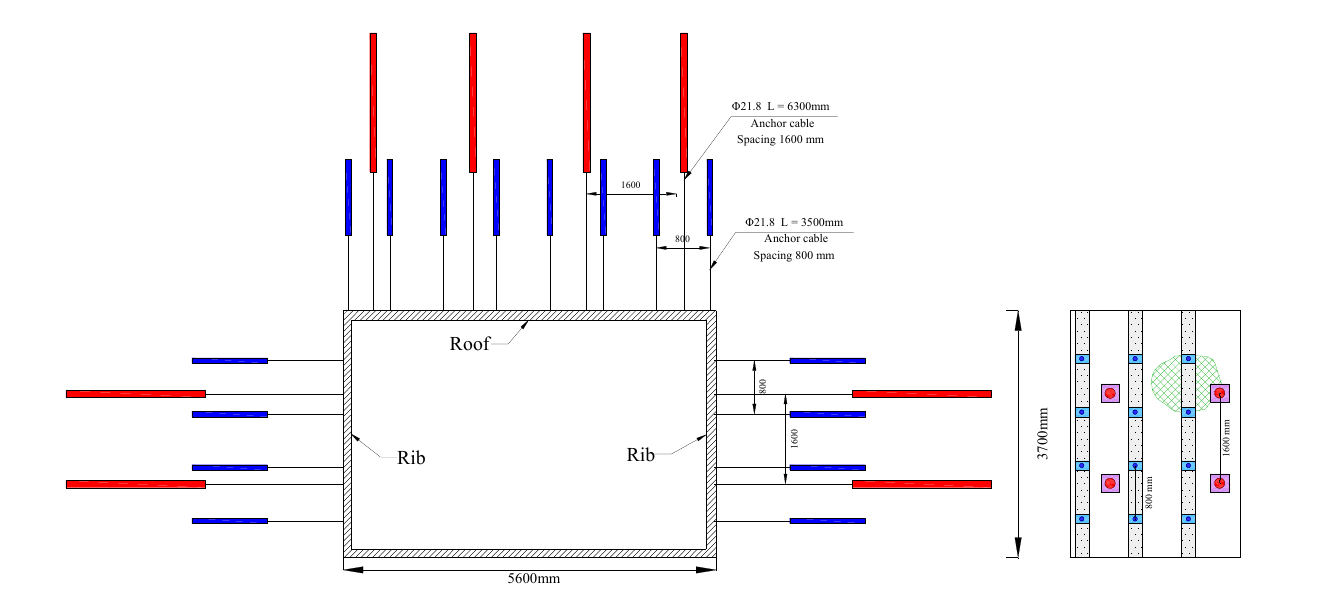
Figure 5. Roadway support parameters.